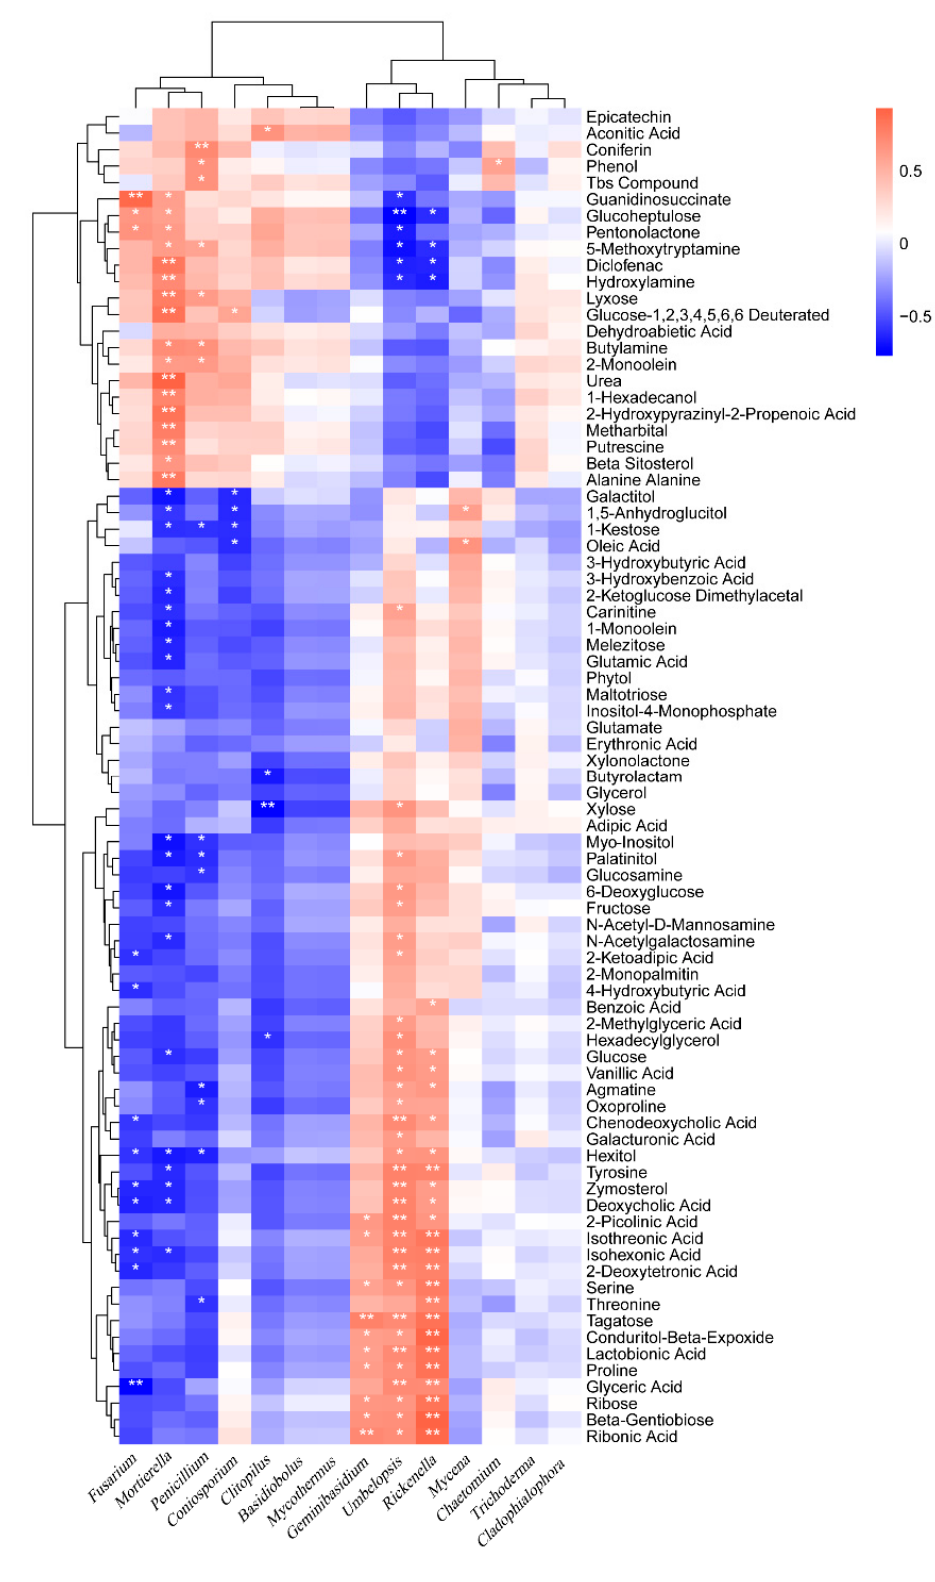
Figure 9. Correlation analysis between the microorganism relative abundances at the fungal genus level and the relative metabolite contents of the humic acid treatment. “*” and “**” represents a significant correlation at p < 0.05 and p < 0.01, respectively. The magnitude of the correlation coefficient was indicated by the depth of the orange and blue scale, while the orange darker color is the greater positive correlation, and the blue darker color is the greater negative correlation.